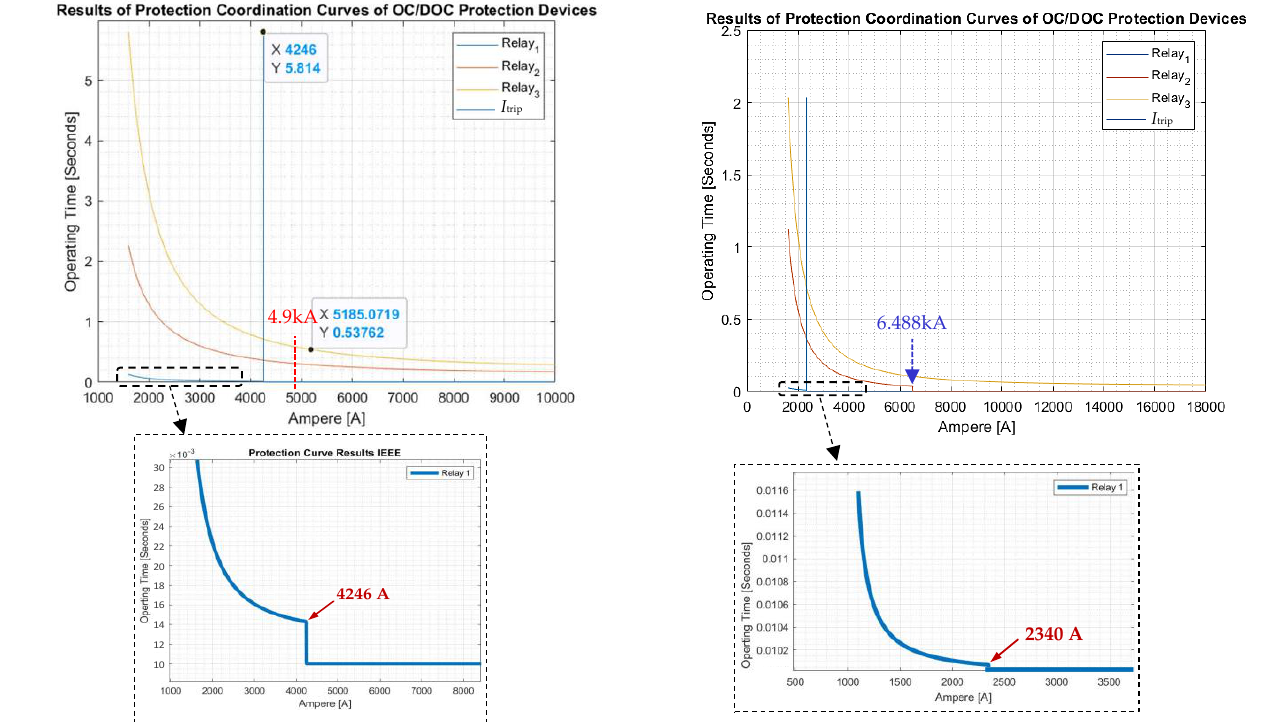
Figure 11. Optimal protection characteristic curves of the OC relays in Scenario 1 of the 22 kV distribution system.